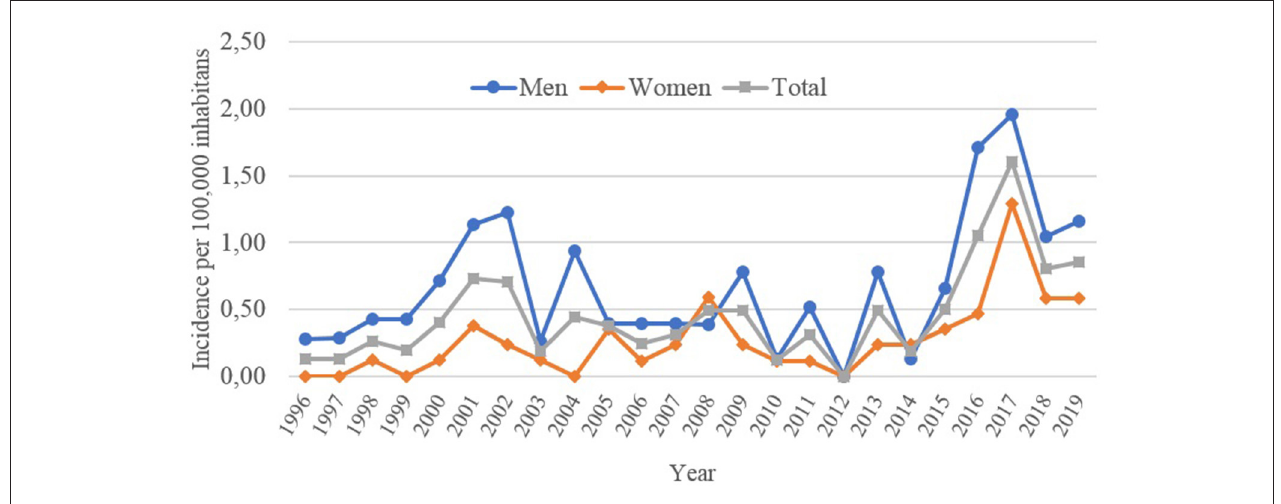
FIGURE 2 | Annual incidence of leishmaniasis per 100,000 inhabitants, by complete sample and sexes. Barcelona, 1996–2019. ( n = 177 cases).